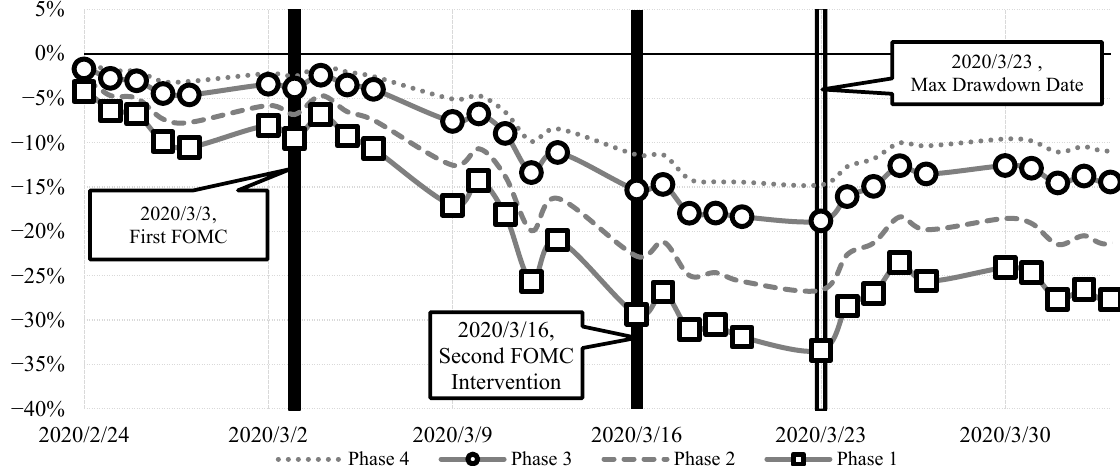
Figure 5. Maximum Drawdown over Sample Period by Portfolio Classification.